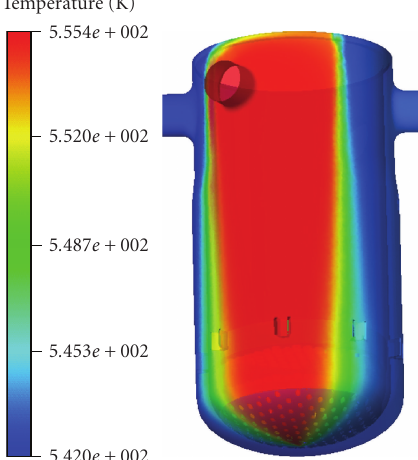
Figure 10: Temperature distribution at the outer wall of the downcomer, SST